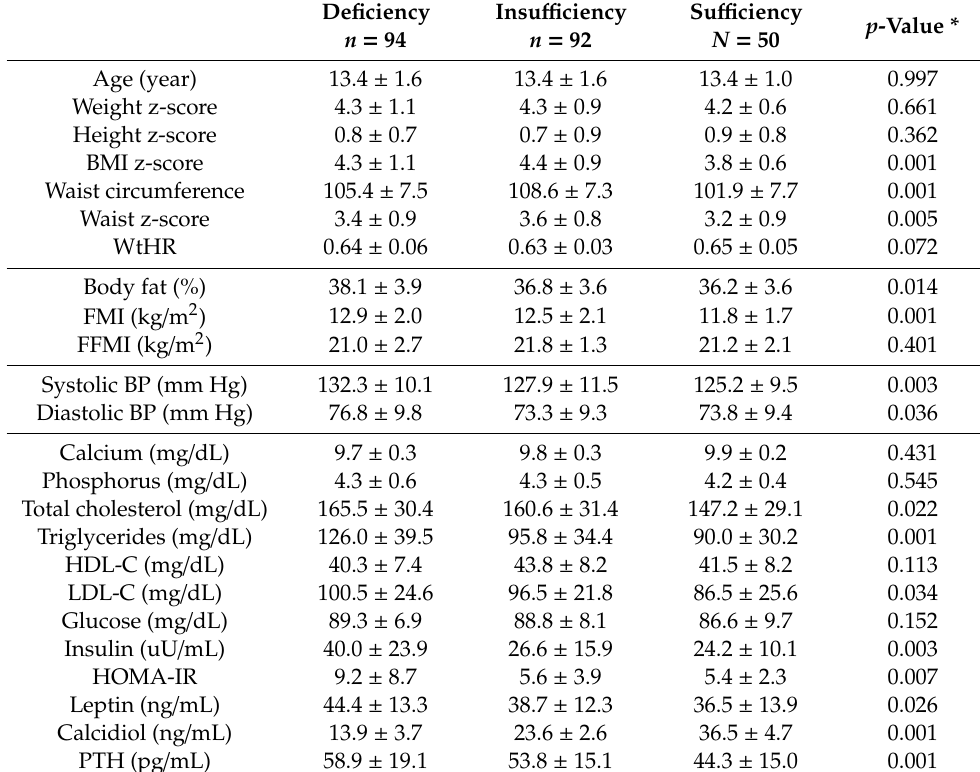
Table 1. Anthropometric and biochemical characteristics according to Vitamin D status.